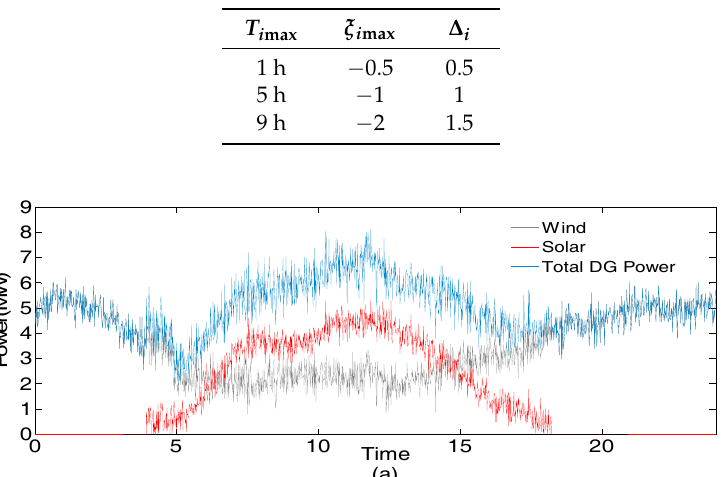
Table 2. Hierarchical T i max s and ξ i max s.